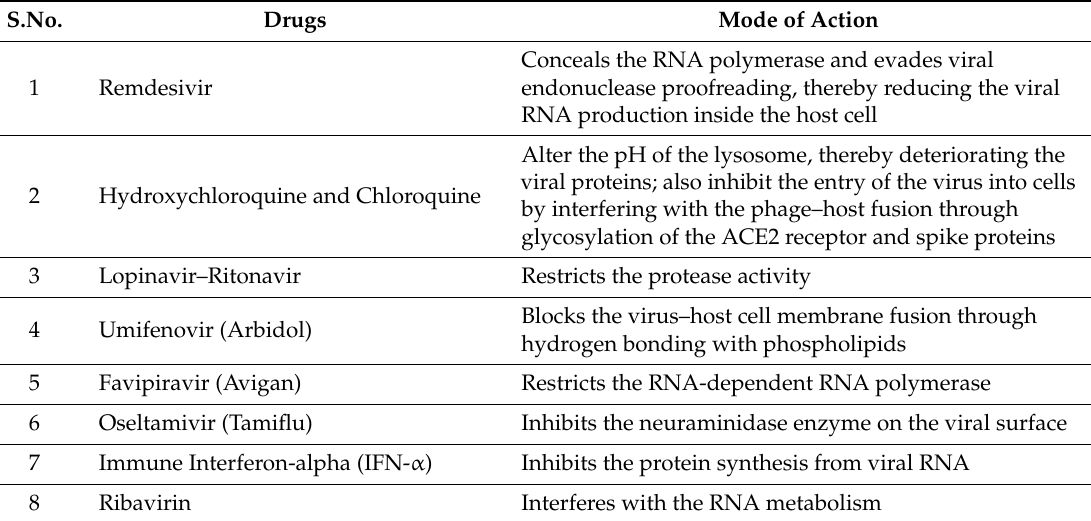
Table 1. Approved antiviral agents